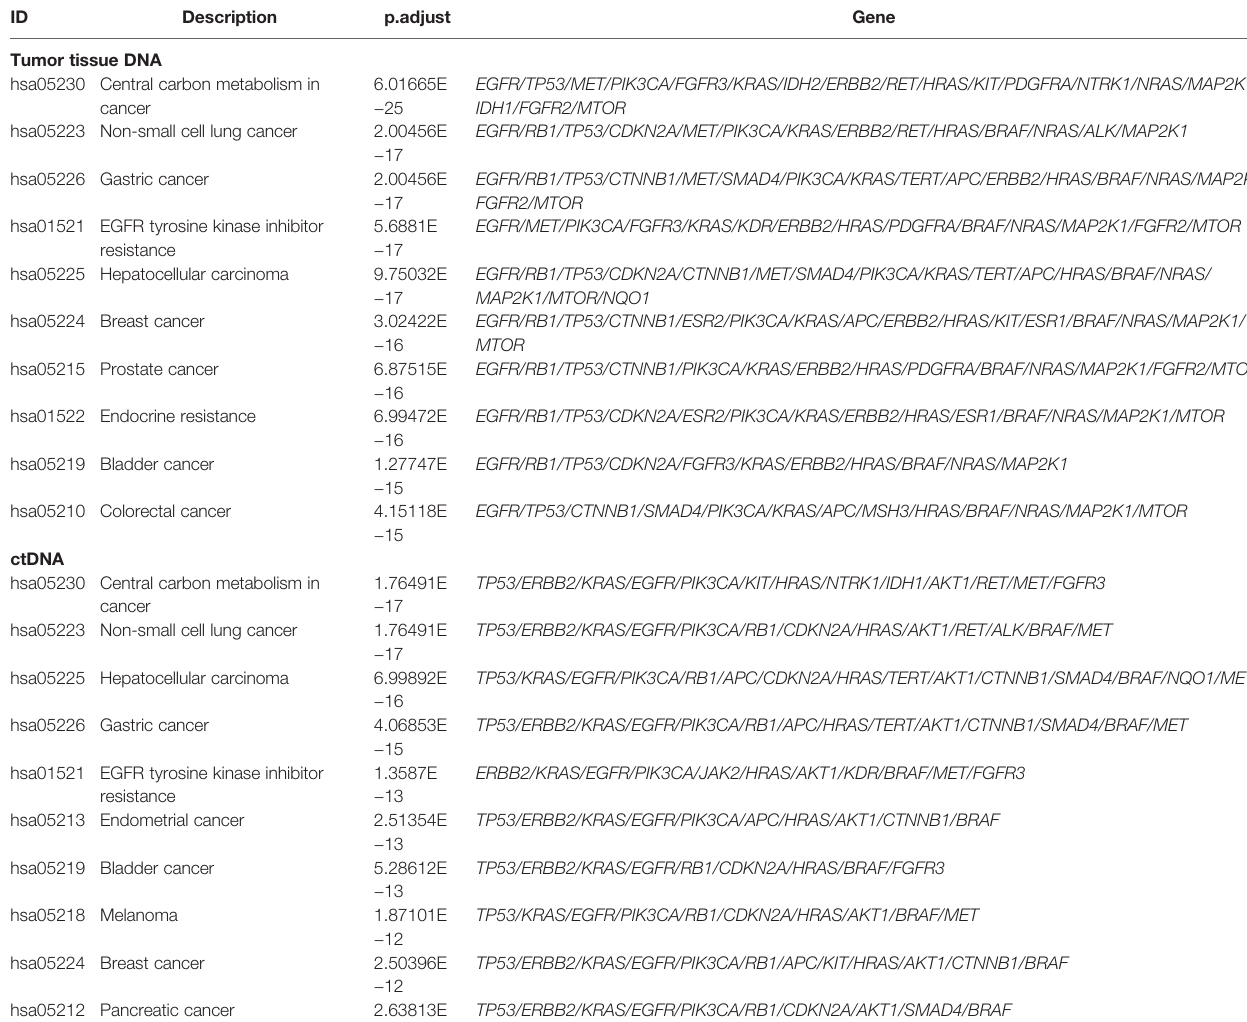
TABLE 2 | Signaling pathways enriched by KEGG analysis of somatic mutations in 199 tumor tissue samples and 125 plasma samples. ID Description p.adjust Gene Tumor tissue DNA hsa05230 Central carbon metabolism in